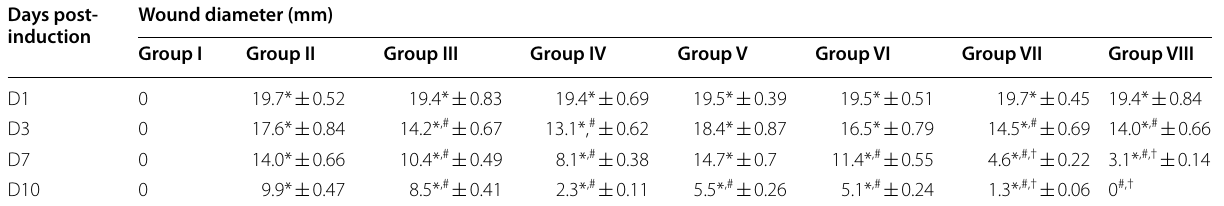
Data are presented as Mean S.D. n 6. Statistical analyses were carried out by Two‑way ANOVA, followed by Tukey’s post‑hoc test. *Significantly different from the ± = corresponding group I (uninjured control) at P < 0.001. # Significantly different from the corresponding group II (injured, infected, untreated) at P < 0.001. † Significantly different from the corresponding group IV (injured, uninfected, untreated) at P < 0.001. Group I: control, intact, non‑infected, untreated, Group II: control, injured, infected, untreated, Group III: control, injured, infected, vehicle, Group IV: control, injured, non‑infected, untreated, Group V: injured, infected, treated with Formula 1 (2% LRJ 25% GE), Group VI: injured, infected, treated with Formula 2 (4% LRJ 25% GE), Group VII: injured, infected, treated with Formula 3 (2% LRJ + + Group VIII: injured, infected, treated with Formula 4 (4%